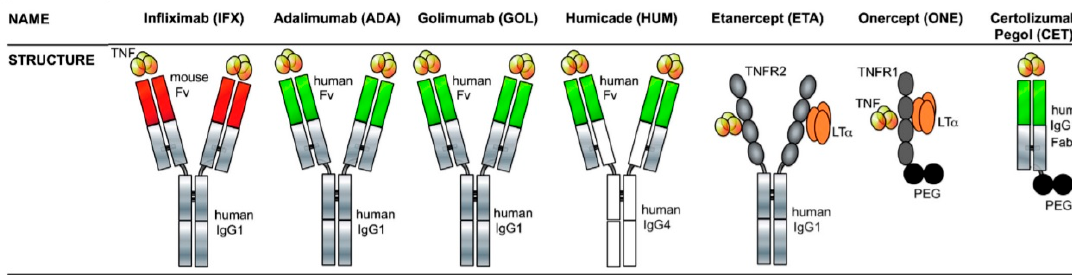
Figure 2. Overview of anti-TNF- α biologicals relevant for IBD. Humicade is CDP571. Abbreviations: Overview of anti-TNF- α biologicals relevant for IBD. Humicade is